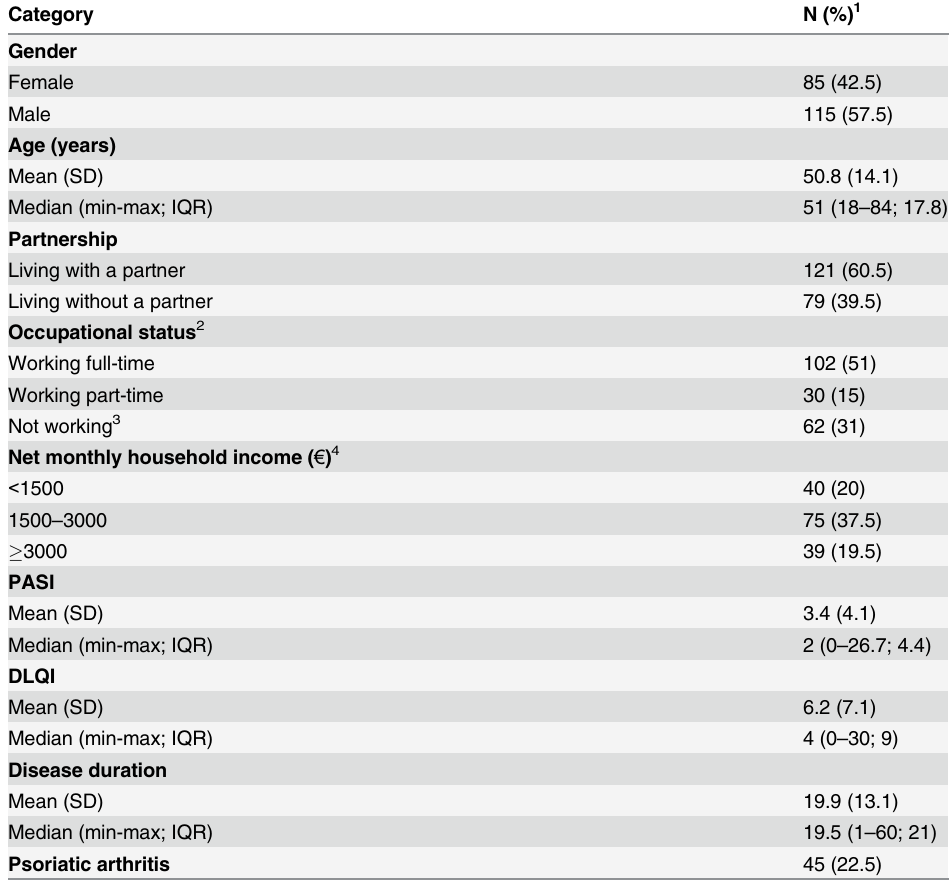
Table 3. Characteristics of the study